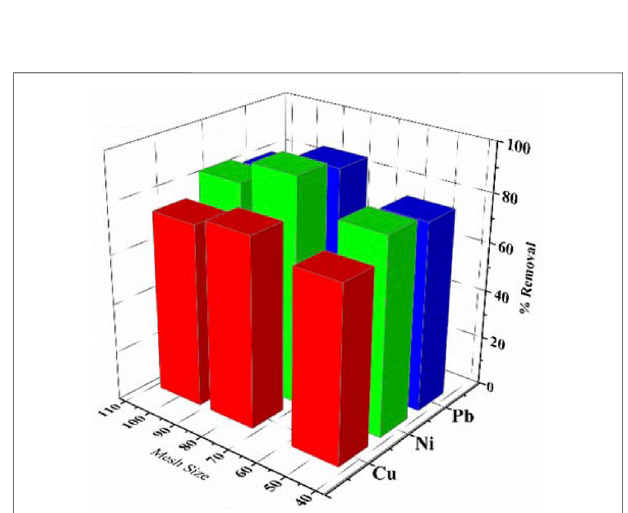
Frontiers in Environmental Science |